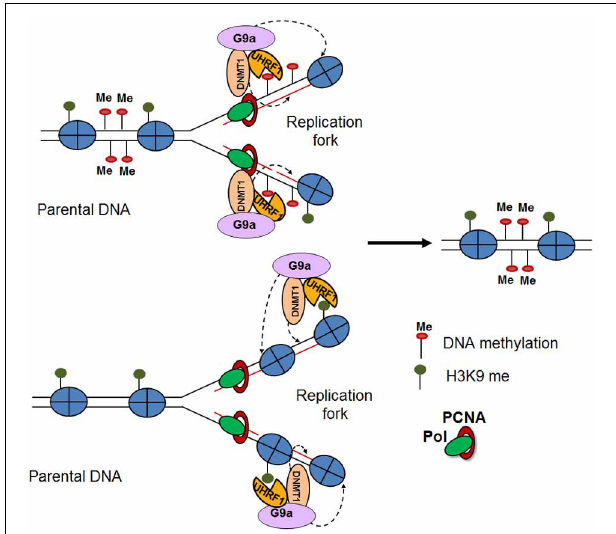
FIGURE 2 | Modification reinforcement model (Zhu and Reinberg, 2011). DNA replication results in hemi-methylated daughter DNA strands. UHRF1 recognizes the hemi-methylated DNA and recruits DNMT1 to restore the DNA methylation pattern on the newly-synthesized DNA. The interaction of DNMT1 with G9a, results in posttranslational modifications of the newly deposited histones (top). Furthermore, H3K9me2/3 mark recruits UHRF1 and DNMT1-G9a, thereby facilitating DNA and H3K9 methylation